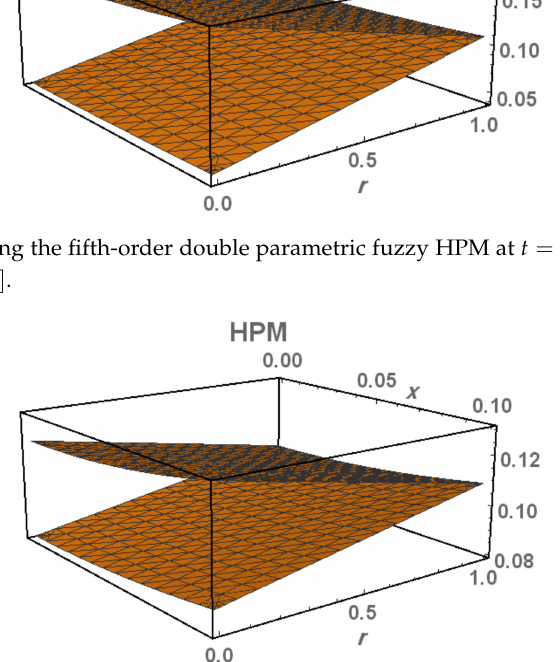
Figure 6. Solution using fifth-order double parametric fuzzy HPM at t = 0.1, b = 0.4,0.6 for all x ∈ [ 0,0.1 ] and r ∈ [ 0,1 ]